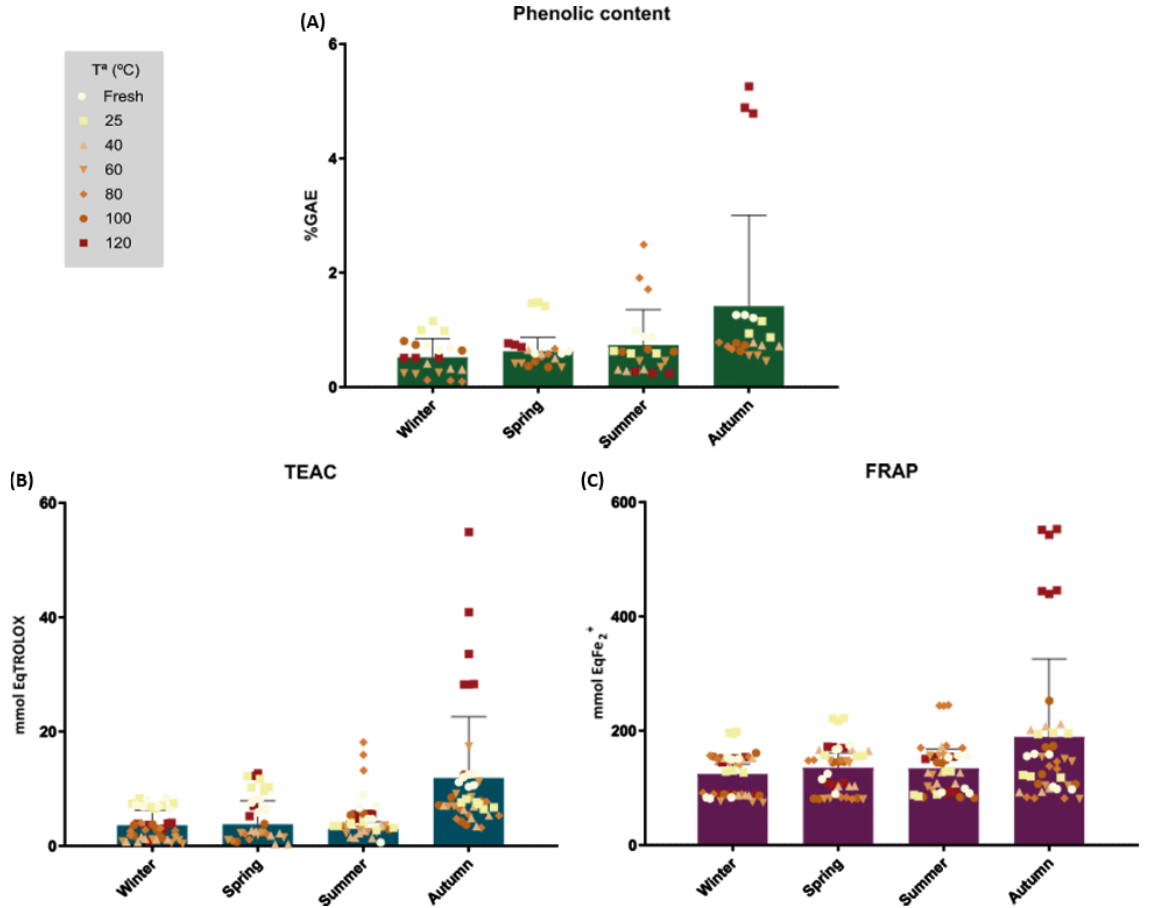
Figure 1. Phenolic content ( A ) and antioxidant capacity measured by TEAC ( B ) and FRAP ( C ) assays. Data are shown as a function of the collection season and drying temperature. ( A ) Data are expressed as the mean (n = 3) of the percentage of gallic acid equivalents per 100 g of each extract. ( B ) Data are expressed as the mean (n = 3) of mmol equivalents of Trolox per 100 g of each extract. ( C ) Data are expressed as the mean (n = 3) of mmol equivalents of Fe 2 + per 100 g of each extract. Statistically significant differences were not noted among the samples.